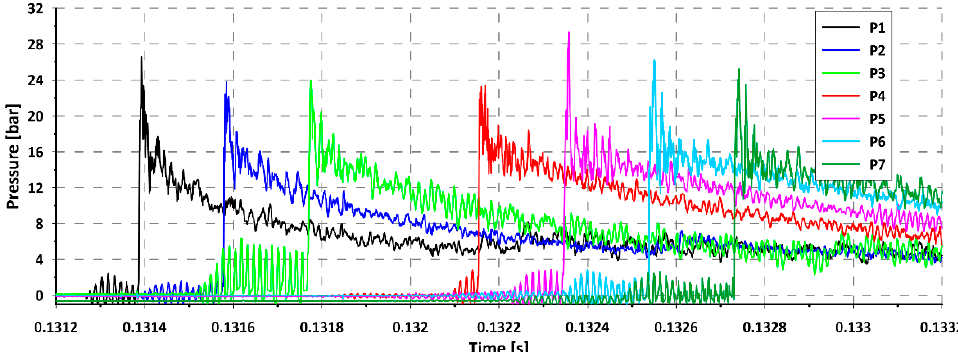
Figure 2. Exemplary pressure traces from an experiment.